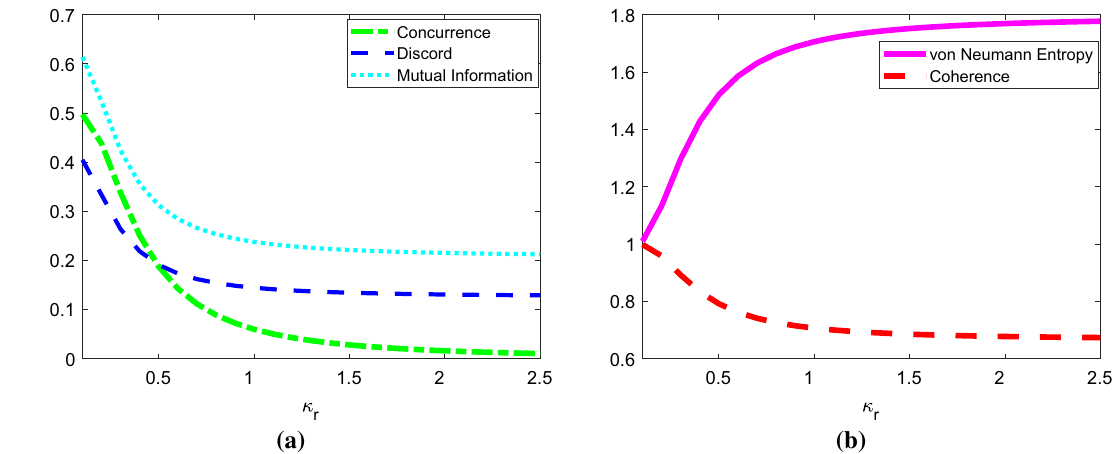
Fig. 3 Quantum correlations at equilibrium state vs. κ r . Other parameters are the same as those in Fig. 2